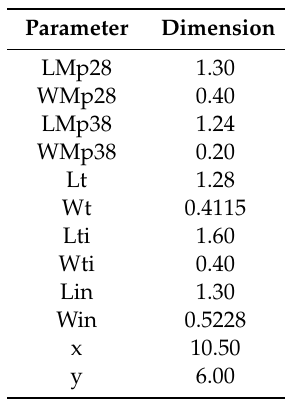
Table 1. Dual-Band Antenna’s Dimensions.